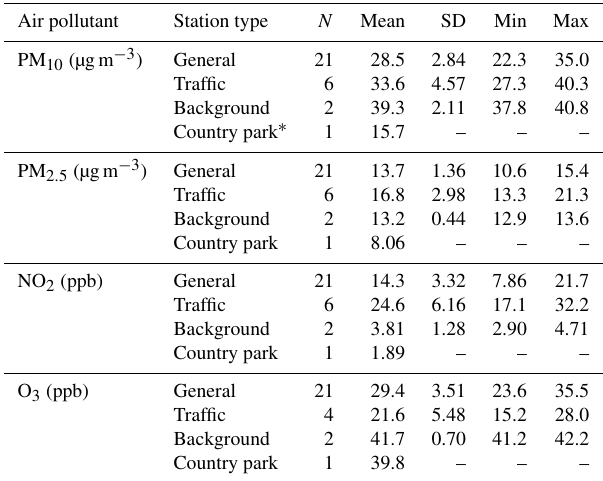
Table 1. Statistical description of measured air pollutants by differ- ent types of